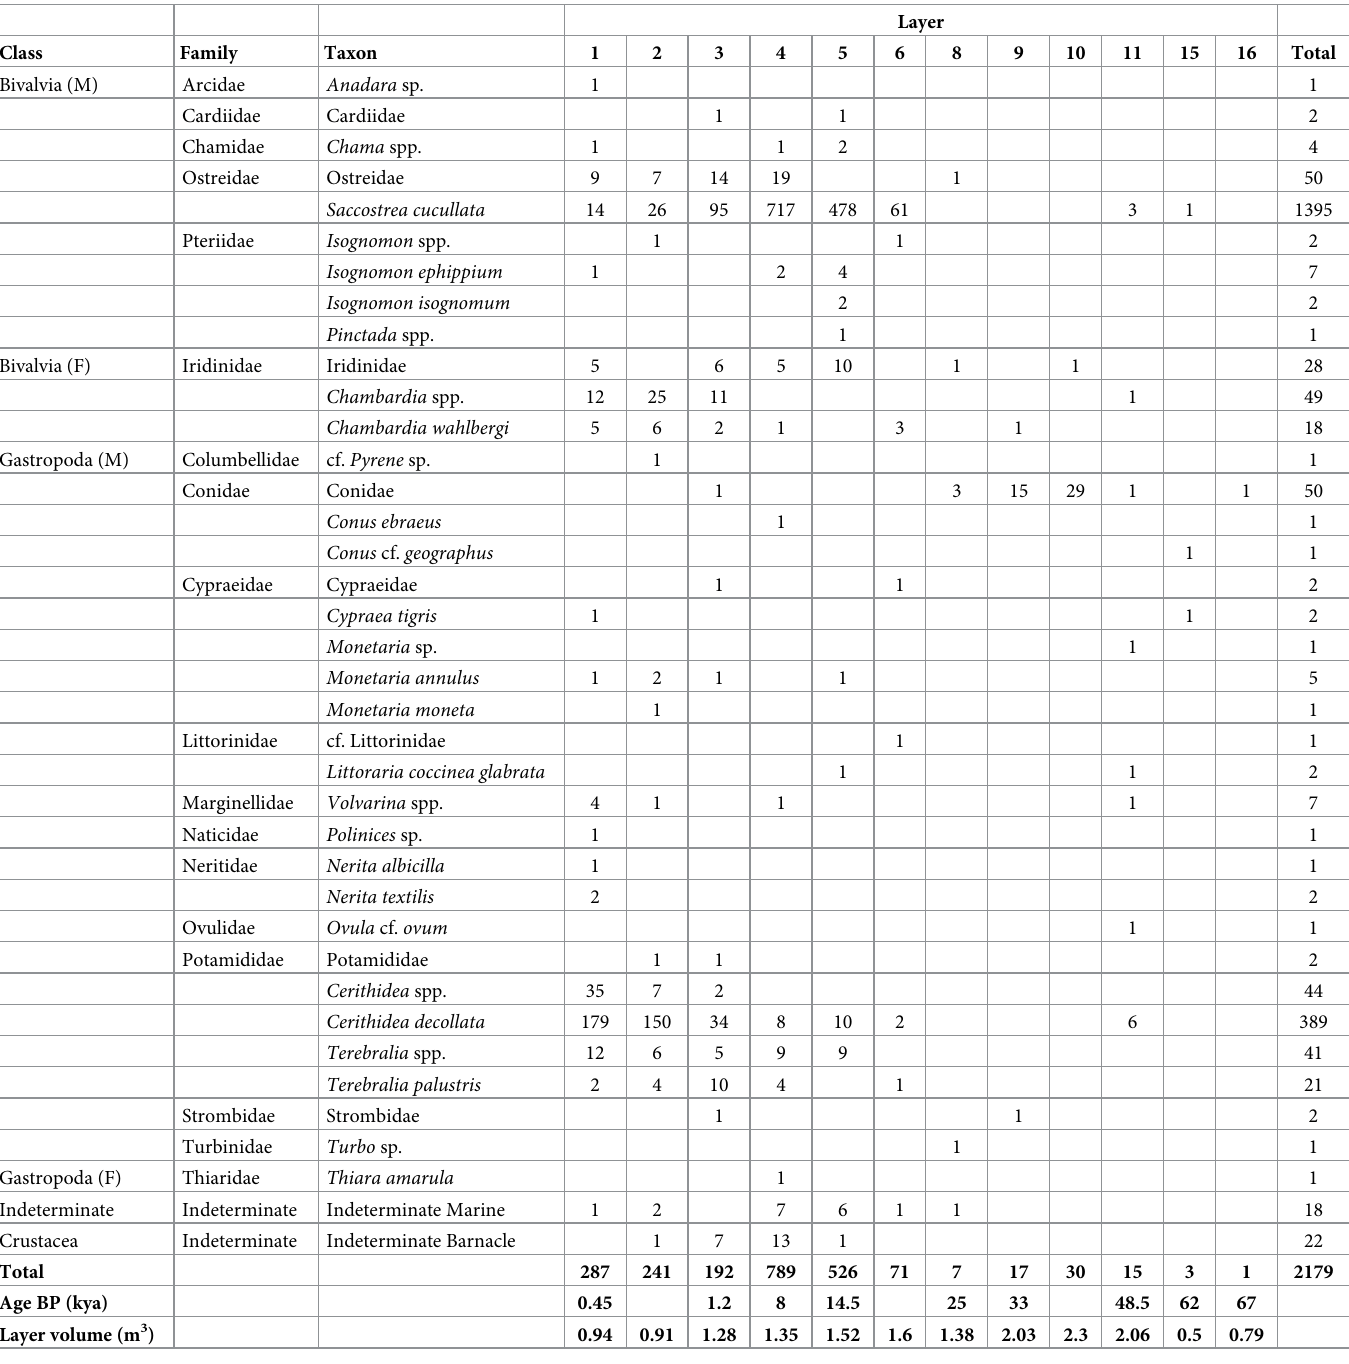
Table 1. PYS invertebrate NISP by